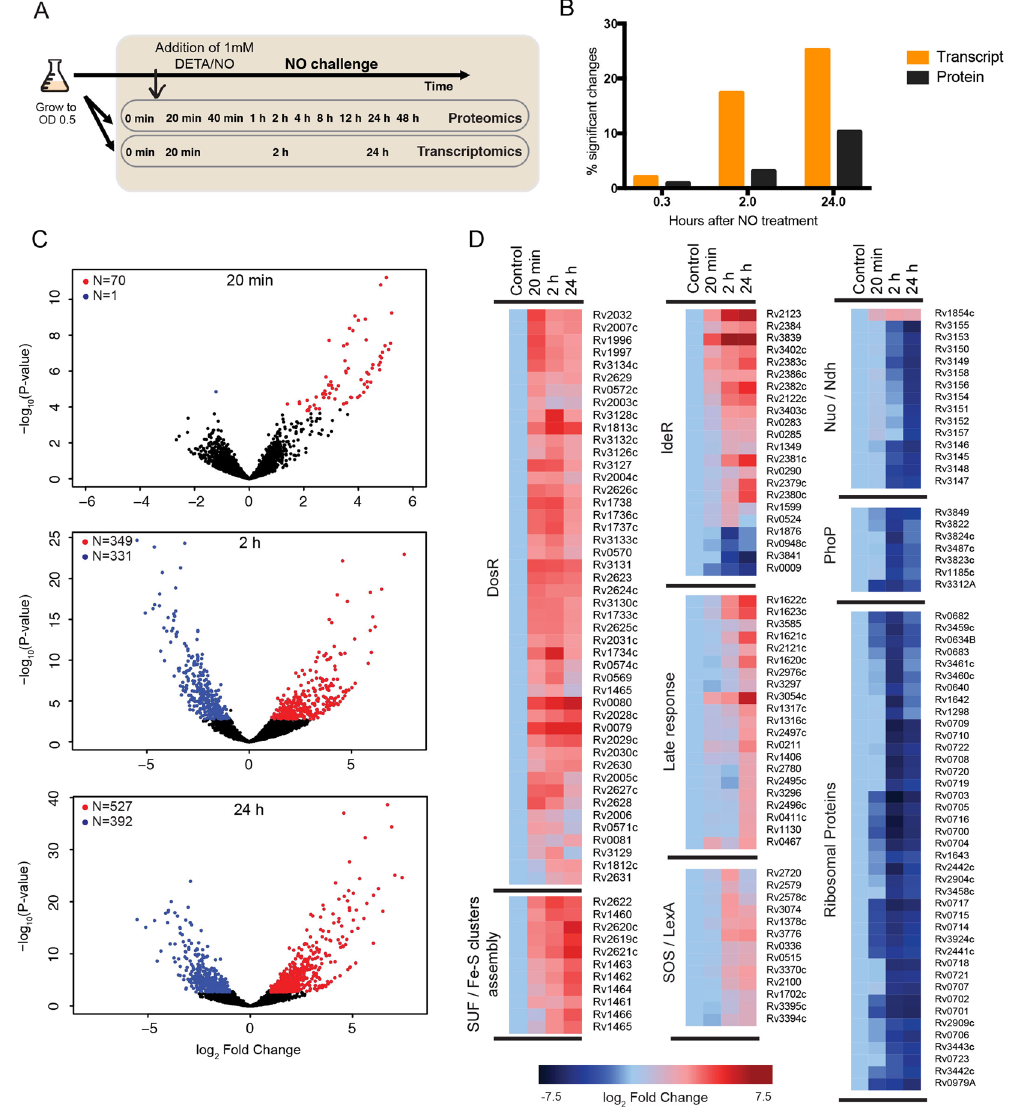
Figure 1. Impact of nitric oxide on the Mycobacterium tuberculosis transcriptome. ( A ) Diagram of the experimental procedure. Cultures were grown to mid-exponential phase and DETA/NO was added once at time point 0 to a final concentration of 1 mM. Samples for transcriptomic and proteomic analysis were harvested from the same cultures during a 48-hour time course at the indicated time points. All experiments were performed in triplicate. ( B ) Kinetics of transcript and protein changes in response to NO. Graph showing the percentage of significantly changing genes and proteins among the detectable transcriptome and proteome, respectively, in response to the challenge with NO. ( C ) Time course of transcriptional changes in response to NO. Volcano plots showing mRNA fold changes compared to time point 0 for all genes upon challenge with NO. Red corresponds to genes with > 1 log 2 fold differential expression and adjusted P-value < 0.01. Blue corresponds to genes with <− 1 log 2 fold differential expression and adjusted P-value < 0.01. ( D ) Transcriptional regulation in response to NO. Heat map of log 2 fold changes for differentially expressed transcripts in response to NO grouped by relevant